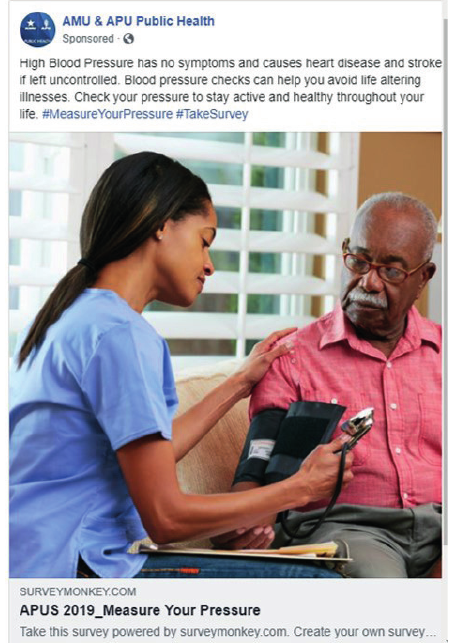
Figure 3. Facebook ad-Web-based survey recruitment, (Measure Your Pressure) MYP